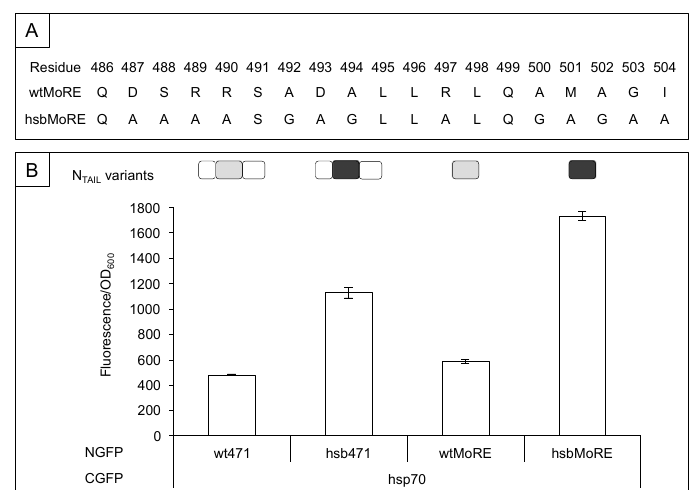
Figure 4. Binding abilities of hsb towards hsp70. ( A ) Amino acid sequence of wt and hsbMore. In the latter, all the residues individually shown to lead to increased N TAIL -hsp70 binding strength by the alanine scanning mutagenesis were collectively replaced with alanine, or with glycine when the wild-type residue was alanine. ( B ) Binding abilities of N TAIL variants as obtained by split-GFP complementation assays. Y -axis: fluorescence values of each culture divided by the optical density at 600 nm. X -axis: N TAIL variants-hsp70 pairs. Shown are the mean values and SD of an experiment performed in triplicate. The scheme of the N TAIL constructs is shown above the graph, with wt and hsb MoREs being represented in grey and black, respectively, and fuzzy regions in white. Orientation is from left (N-terminal end) to right (C-terminal end). Data were taken from [66].